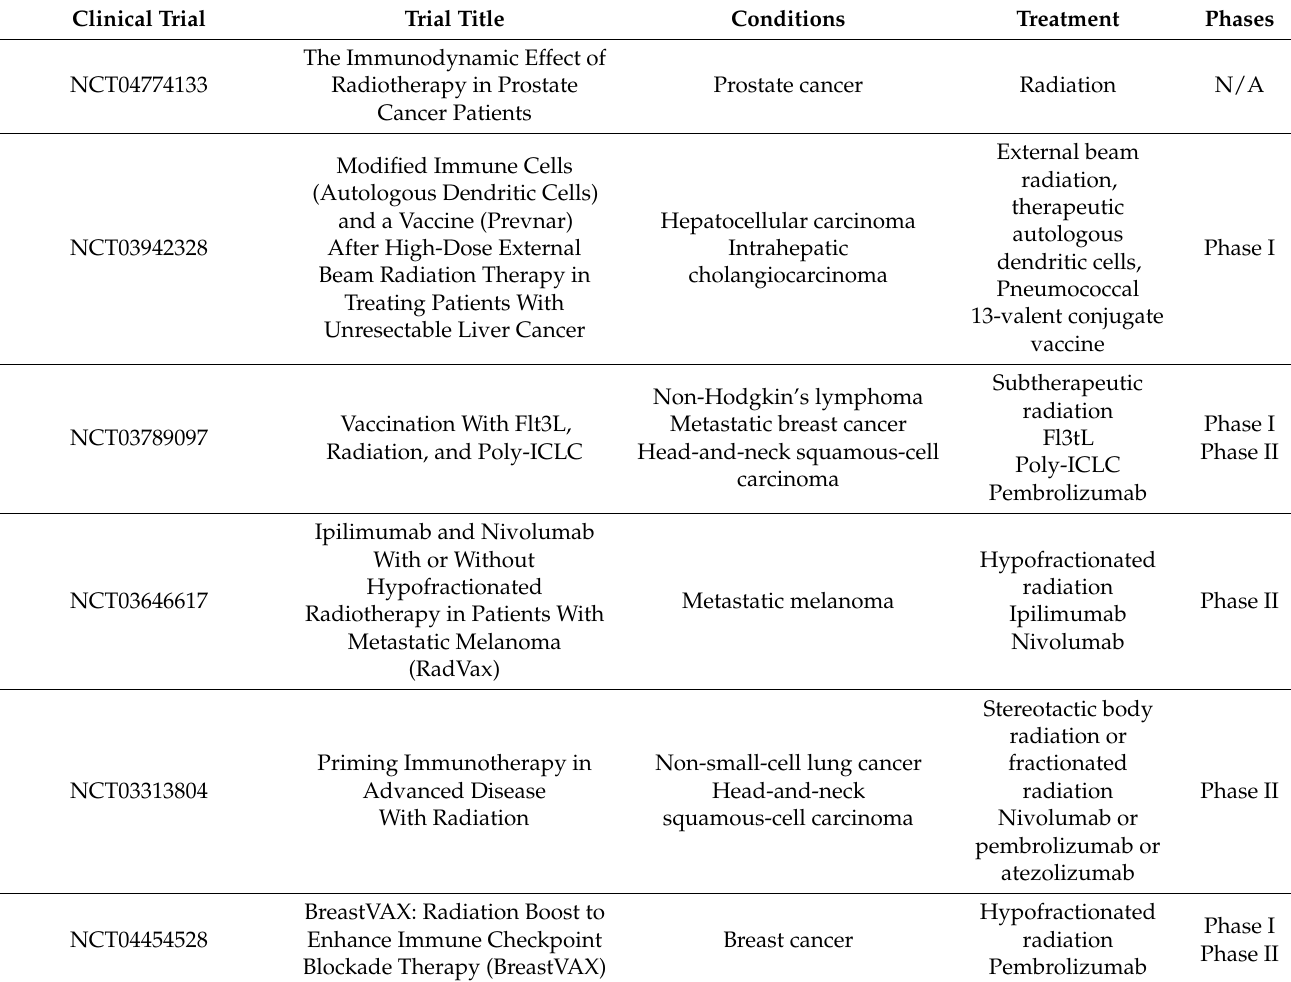
Table 2. Clinical trials investigating immunogenic cell stress mediated by